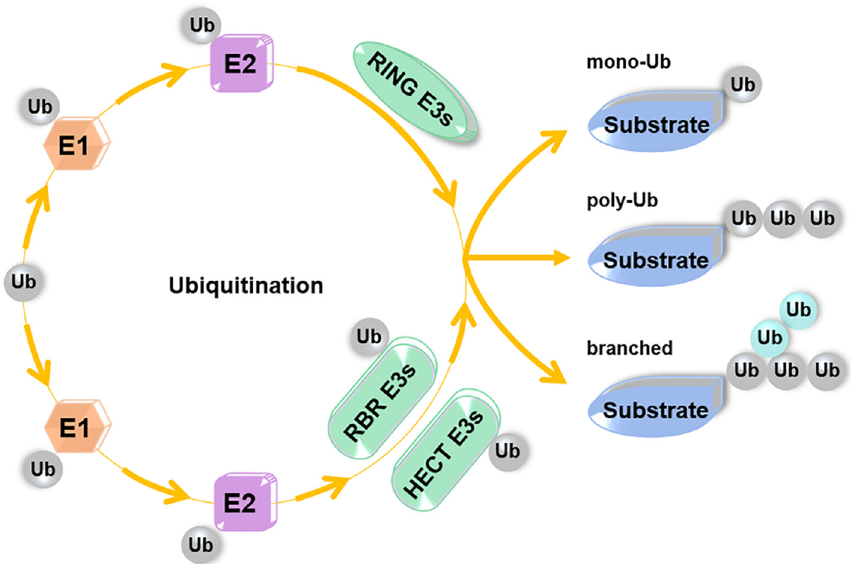
Figure 2. The process of ubiquitination. E1 activates Ub to form the E1-Ub intermediate. Next, E2 catalyzes transthiolation reaction to transfer Ub from the E1-Ub complex to its active C site. An E3 ligase is responsible for the final reaction. RING-type E3s facilitate direct Ub transfer from E2s to substrates, whereas HECT-type and RBR-type E3s adopt two-step reactions for Ub conjugation. Substrate proteins can be modified by mono-ub or poly-ub chains. A poly-Ub chain can be homotypic with only one linkage type or heterotypic with mixed or branched linkages.